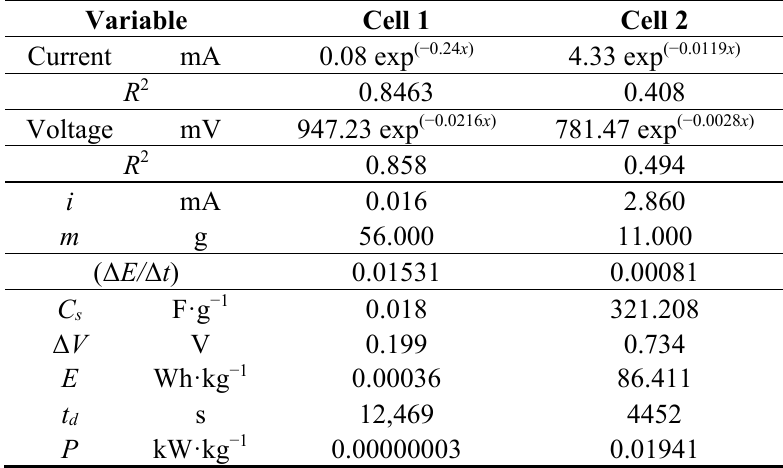
Table 4. Specific capacitance, energy density and power density associated with ZVM TP pellets prior to use in desalination. These pellets were used in ST1a to ST5j (Appendix C), Cell 1 and Cell 2. x = hours since start of